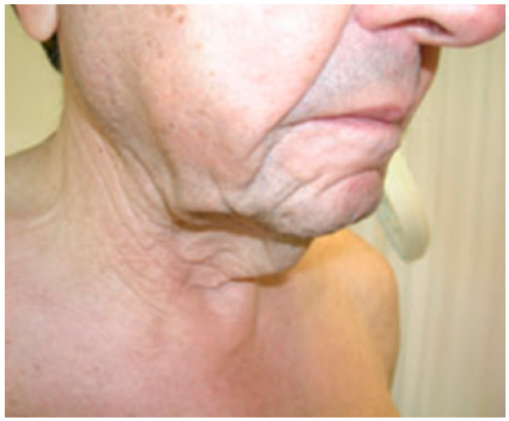
Figure 5. A 52-year-old patient that complaint of premature aging. Skin looks inelastic and pendulous on the neck. Immunofixation was positive for IgG-lambda. Skin biopsy was consistent with cutis laxa.